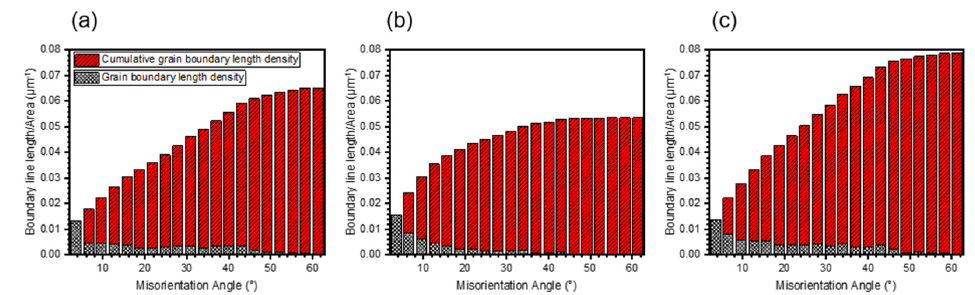
Figure 6. Distributions of grain boundary length density and cumulative grain boundary length density as a function of misorientation angle obtained from EBSD analysis: ( a ) 0 ° sample; ( b ) 55 ° sample and ( c ) 90 ° sample.